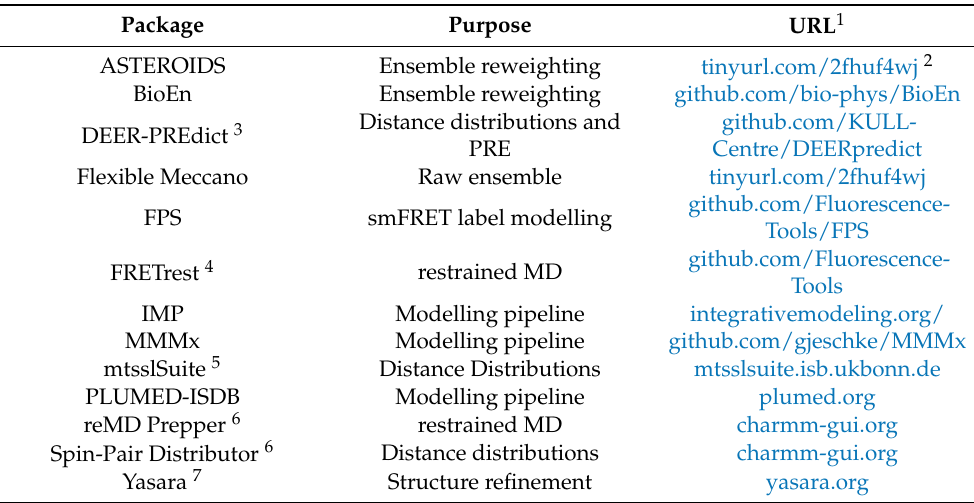
Table 1. Selected software packages for integrative modelling and ensemble modelling with label- based